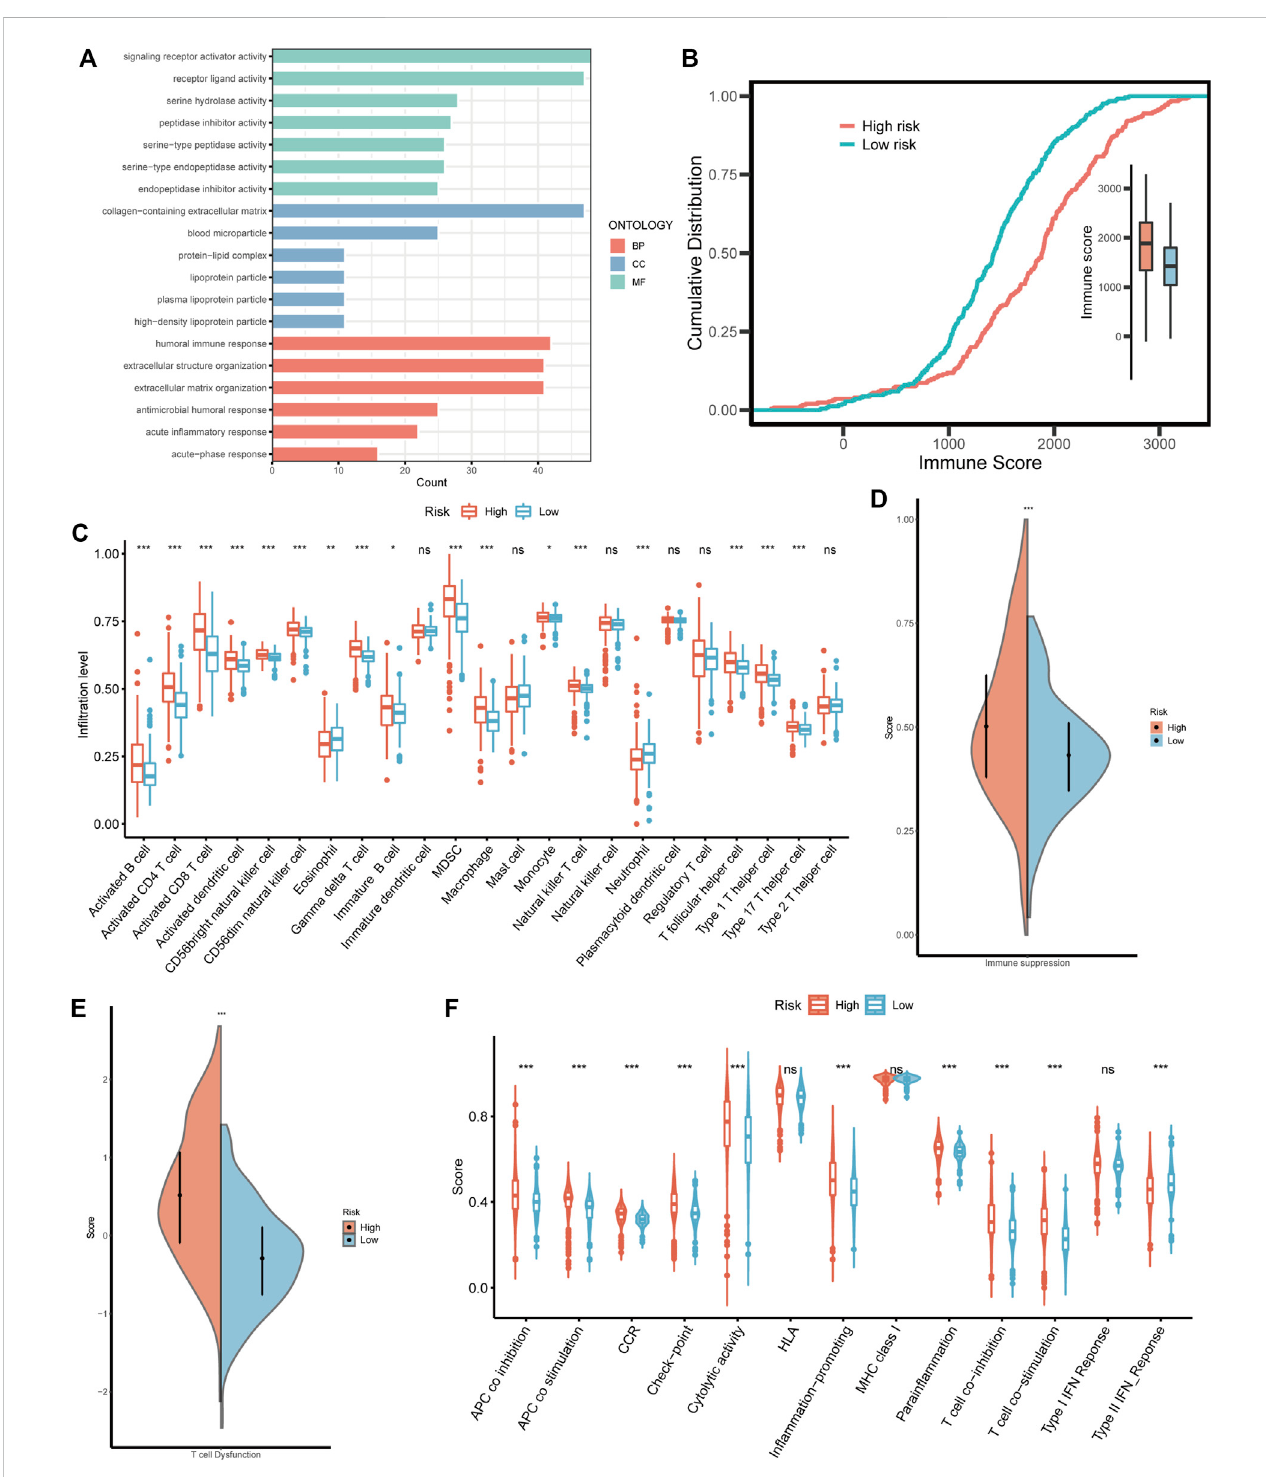
FIGURE 7 The immune landscape in different BMRS risk groups. (A) The enriched GO functions in the high risk group. (B) The different cumulative distributions of the immune score in different risk groups. (C) The distinct in fi ltration level of the immune cells in high and low risk groups. (D, E) Comparison of the scores of immune suppression and T cell dysfunction between the two BMRS groups. (F) The difference in immune functions between high and low risk